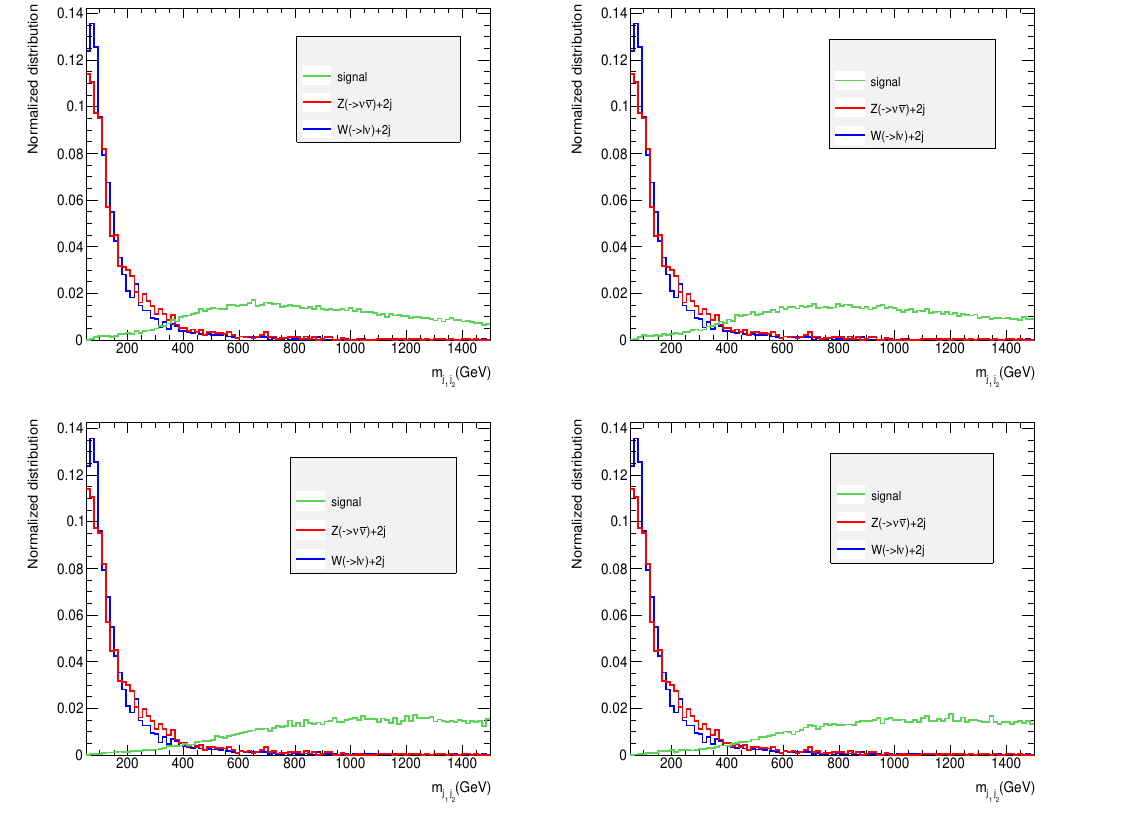
Figure 14 . Invariant mass distribution of the two forward jets for vector boson fusion signal and background processes, Type I BP II(top left), Type I BP I(top right), Type II BP I(bottom left) and Type II BP II(bottom